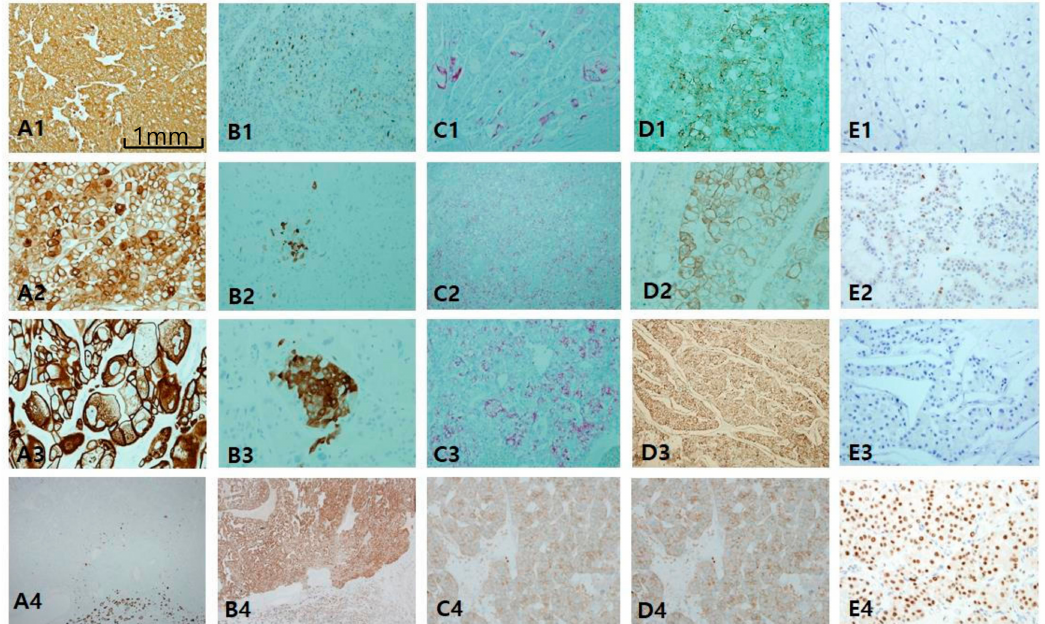
Figure 6. Comparison of chromophobe renal cell carcinoma (ChRCC) with renal oncocytoma (RO). Di ff erential diagnosis between these entities is di ffi cult since they overlap in origin and morphology. ( A1 – A4 ) cytokeratin 7 is highly intense and di ff usely stained in ChRCC in contrast to RO showing